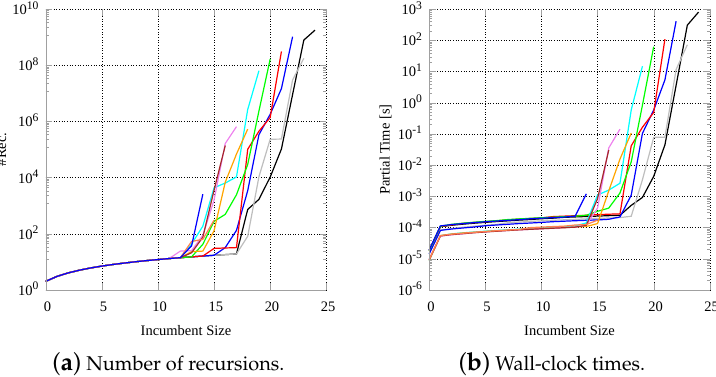
( b ) Wall-clock times. Figure 6. Number of recursions ( a ) and wall-clock times ( b ), in the standard sequential McSplit procedure, as a function of the size of the MCS